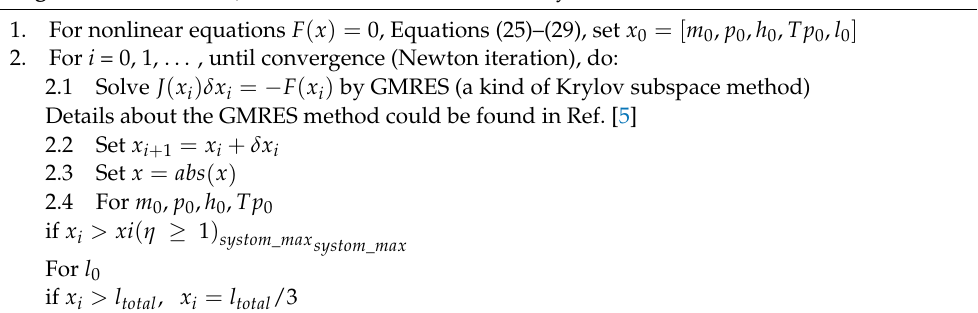
Algorithm 2 Modified JFNK method for HTR secondary